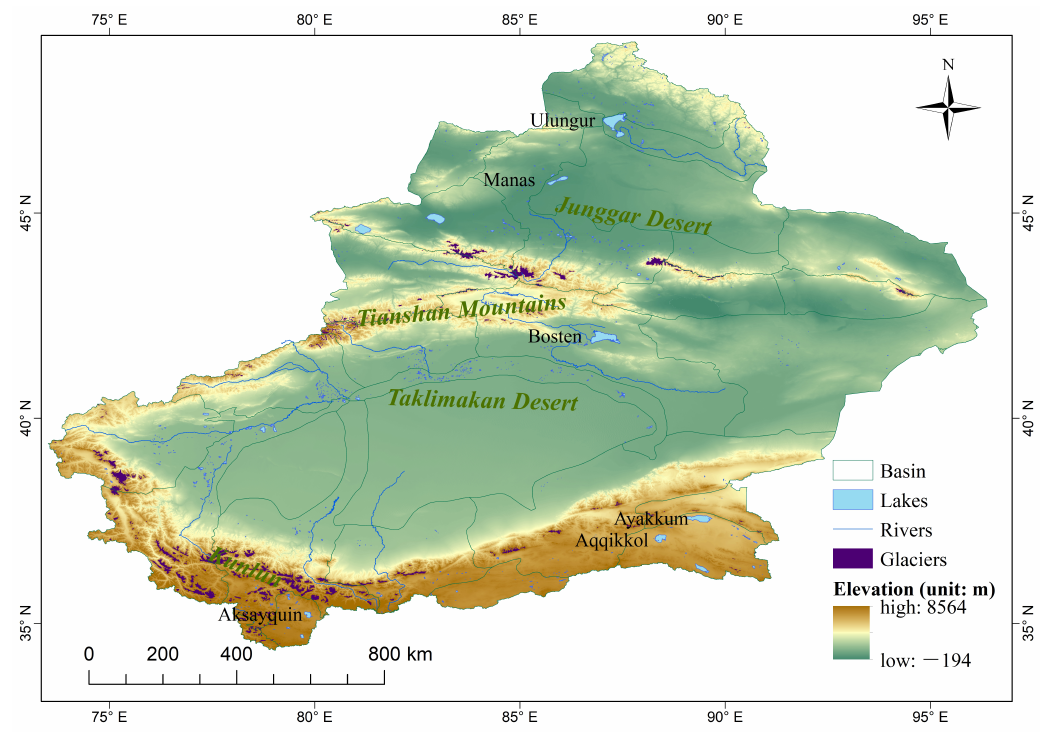
Figure A3. Glacier distribution of